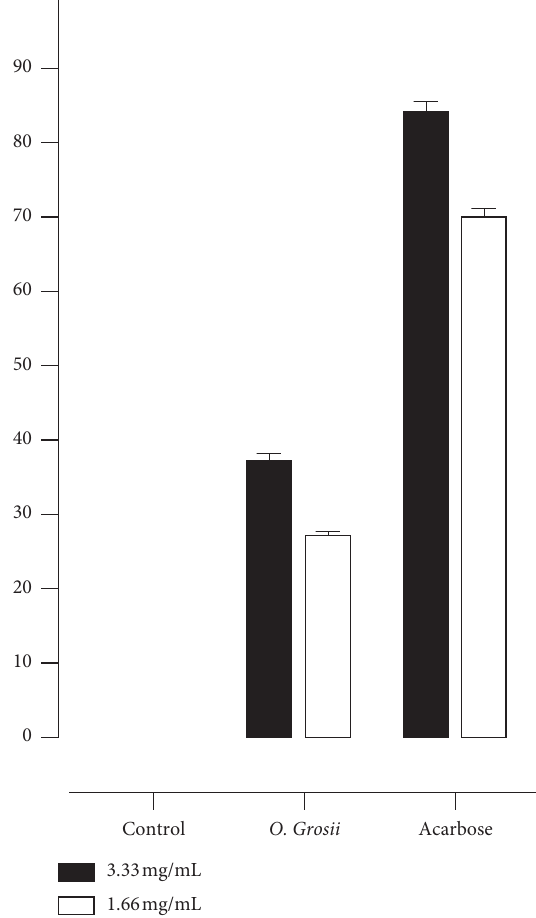
Figure 6: Inhibitory effect of extracts on pancreatic alpha-amylase enzyme activity.